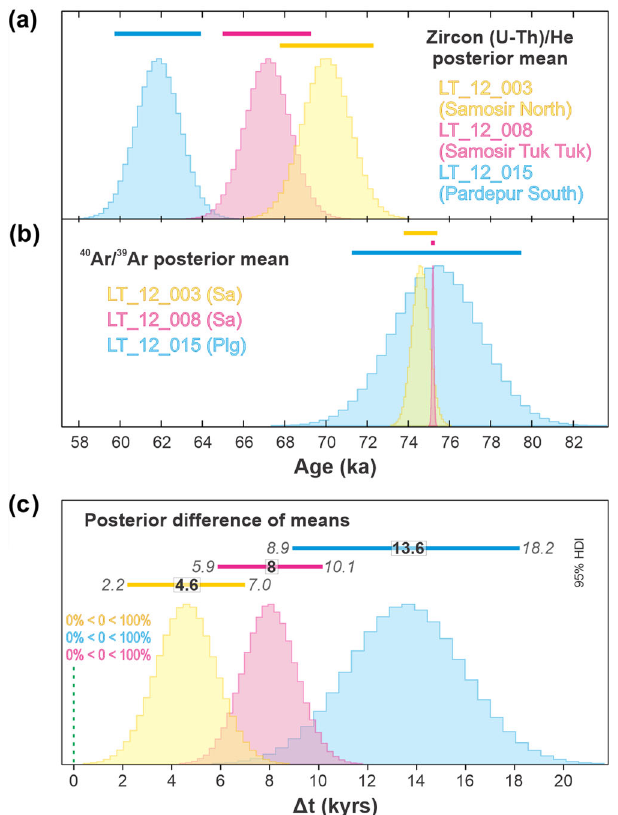
Fig. 3 Histograms of posterior distributions for mean values of ZHe ages, Ar ages, and difference of their mean values using Bayesian analysis. Histograms showing posterior distributions of a credible mean values for ZHe ages, b credible mean values for Ar ages, and c difference of the mean values predicted by Bayesian analysis employing Markov chain Monte Carlo method with 100,000 burn-in and 1,000,000 iterations (see details in Supplementary Note 3). (Note that these histograms are parameter values from the posterior distributions that are permissible or “ credible ” within the measured data. The histograms are not the measured data distributions.) Horizontal bars represent 95% high-density intervals (HDI); for exact values see Table 1. Since the 95% HDI of the difference of means falls above zero and 100% of the predicted credible values are >0, we can conclude that the means of Ar and ZHe datasets are credibly different (full data in Supplementary Fig.